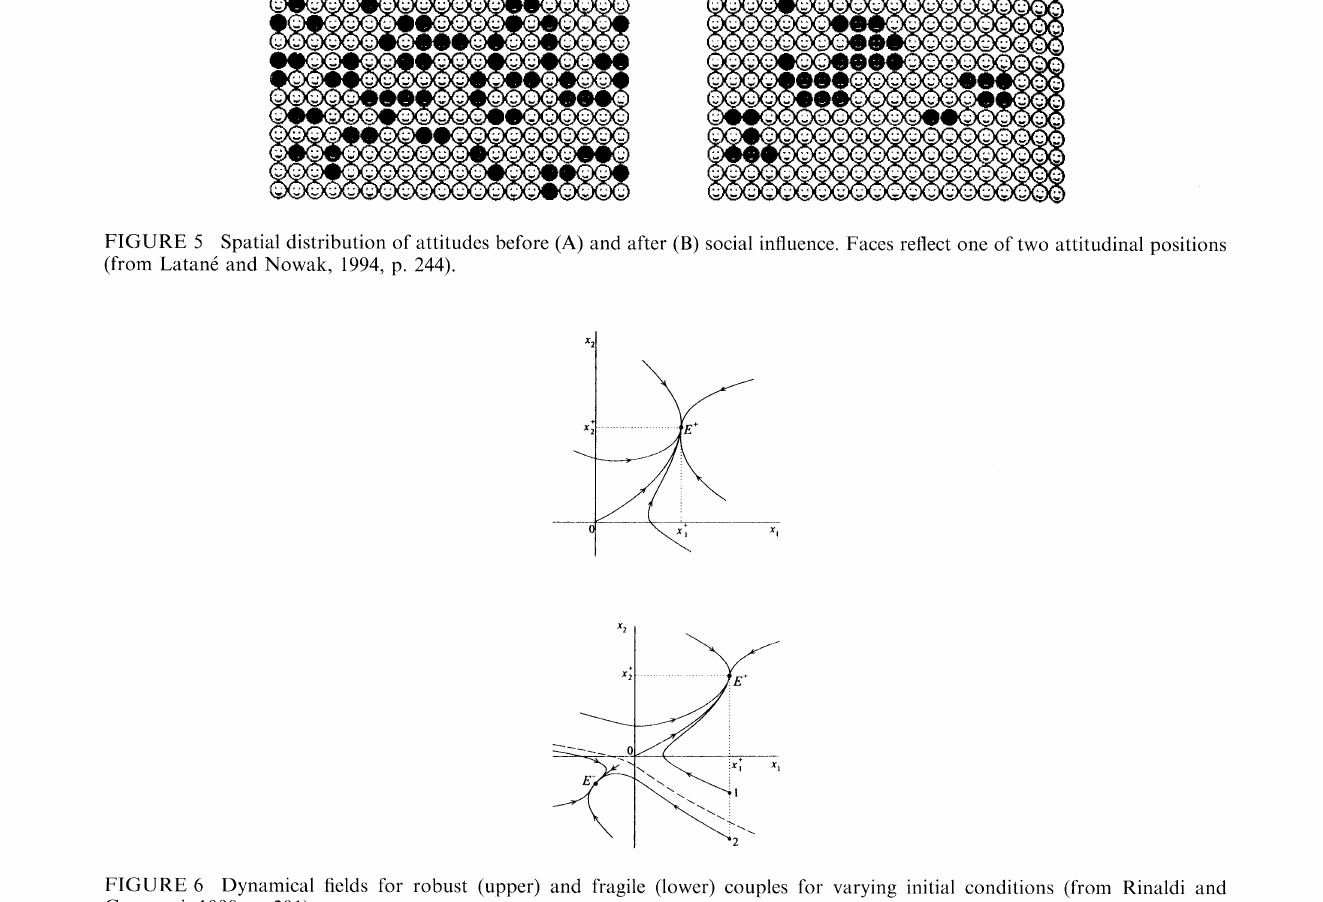
FIGURE 6 Dynamical fields for robust (upper) and fragile (lower) couples for varying initial conditions (from Rinaldi and Gragnani, 1998, p.